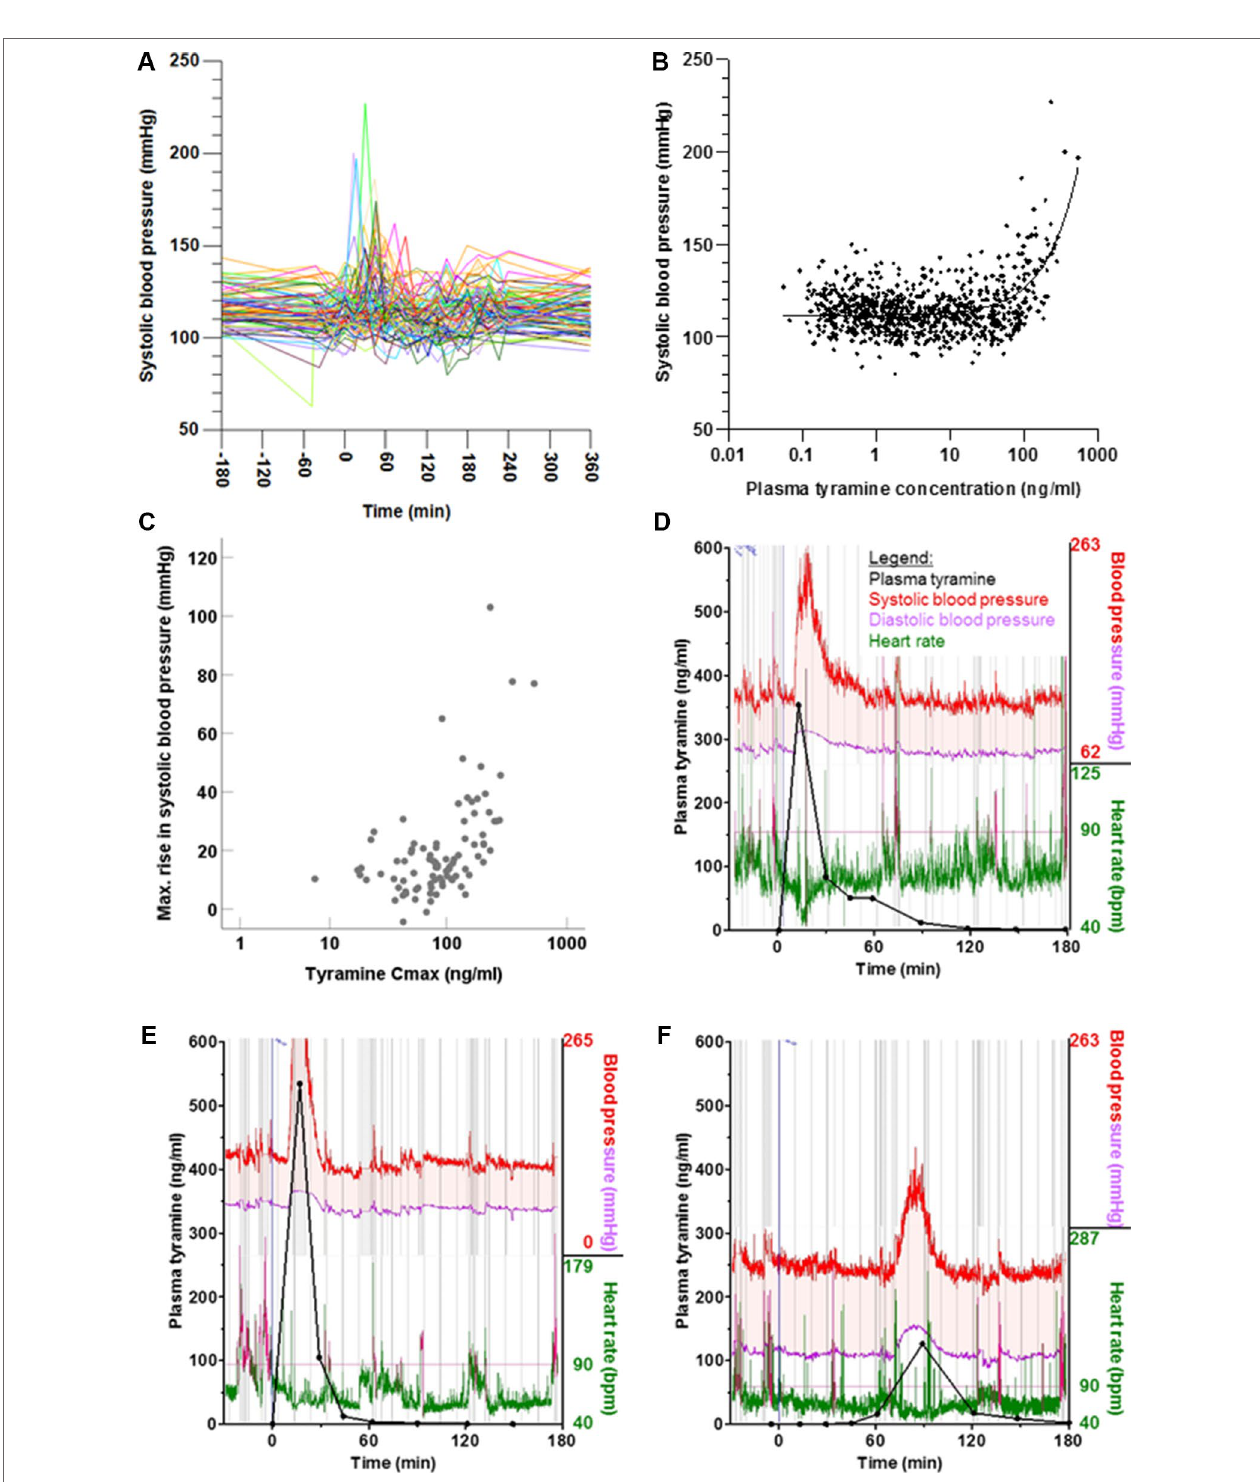
FigUre 6 | (A) Time course of systolic blood pressure shown for each participant. (B) Systolic blood pressure relative to plasma tyramine concentration, shown as individual readings. More information and similar representations for diastolic blood pressure and heart rate are shown in Supplementary Figure 2 . (C) Correlation between maximum systemic tyramine concentration and maximum rise in systolic blood pressure (p < 0.001, two-tailed). (D – F) Individual exemplary time courses of blood pressure and heart rate, measured at very short intervals via the pulse transit time. For reference, the plasma concentrations of tyramine have been